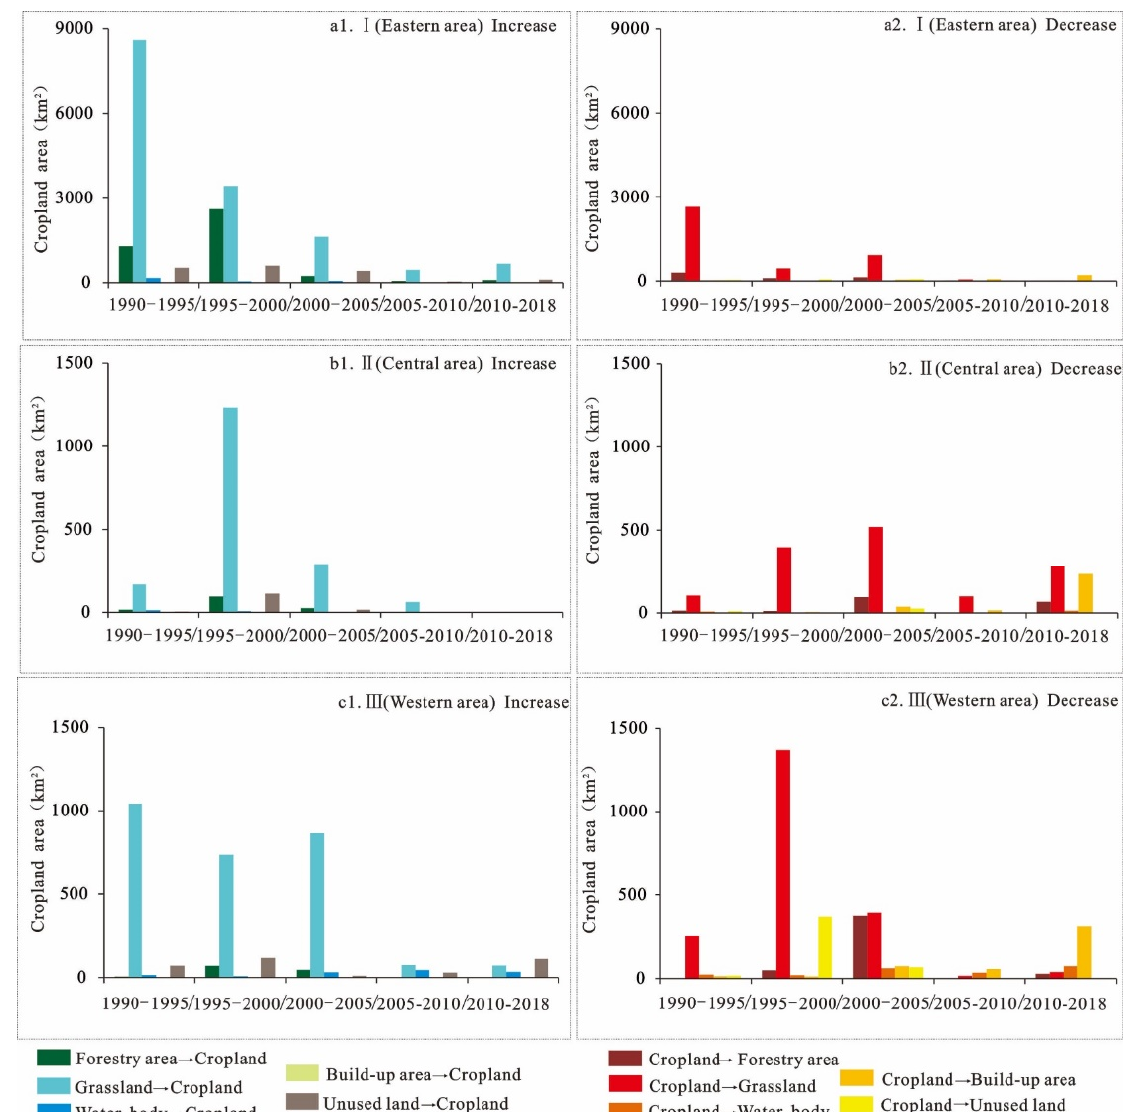
Figure 4. Conversions from or to croplands in three sub-regions of Inner Mongolia of China from 1990 to 2018.